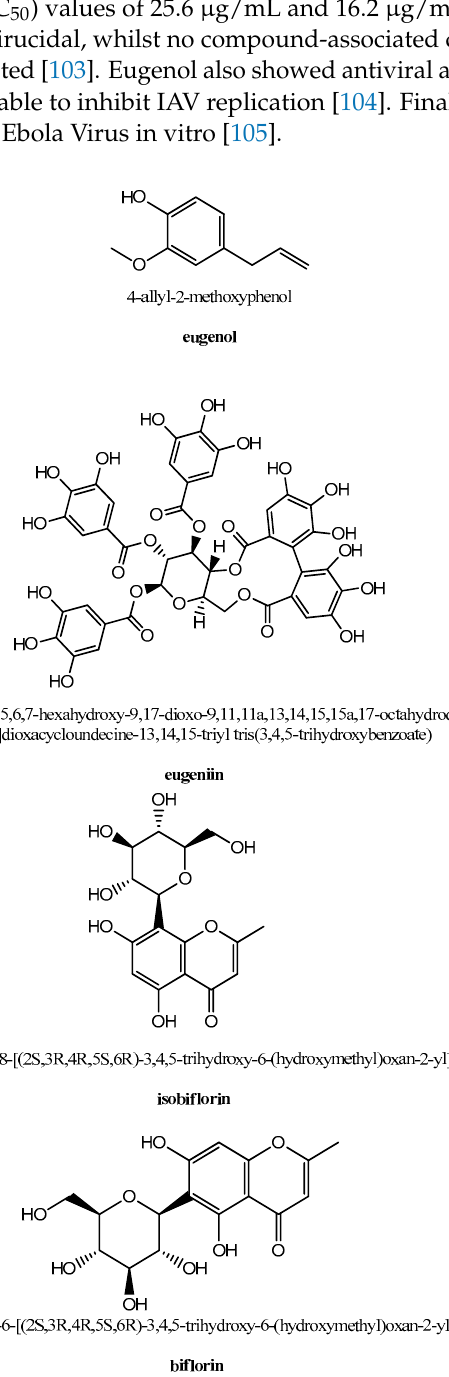
Figure 2. Structure representations of some clove phytochemicals with antiviral activity. Other clove phytochemicals were investigated for their antiviral properties, and among them, eugeniin (Figure 2), isolated from the herbal extracts of cloves and, also, from Geum japonicum , showed anti-HSV activity at a 5- µ g/mL concentration [106]. The HSV inhibitory activity of eugeniin was due to the inhibition of the viral DNA synthesis, as it acted as a selective inhibitor of the DNA polymerases of HSV-1 and HSV-2 [106]. Eugeniin was also found to act as a potent inhibitor of the protease of Dengue virus (DENV), which causes infections in tropical and subtropical regions of the world for